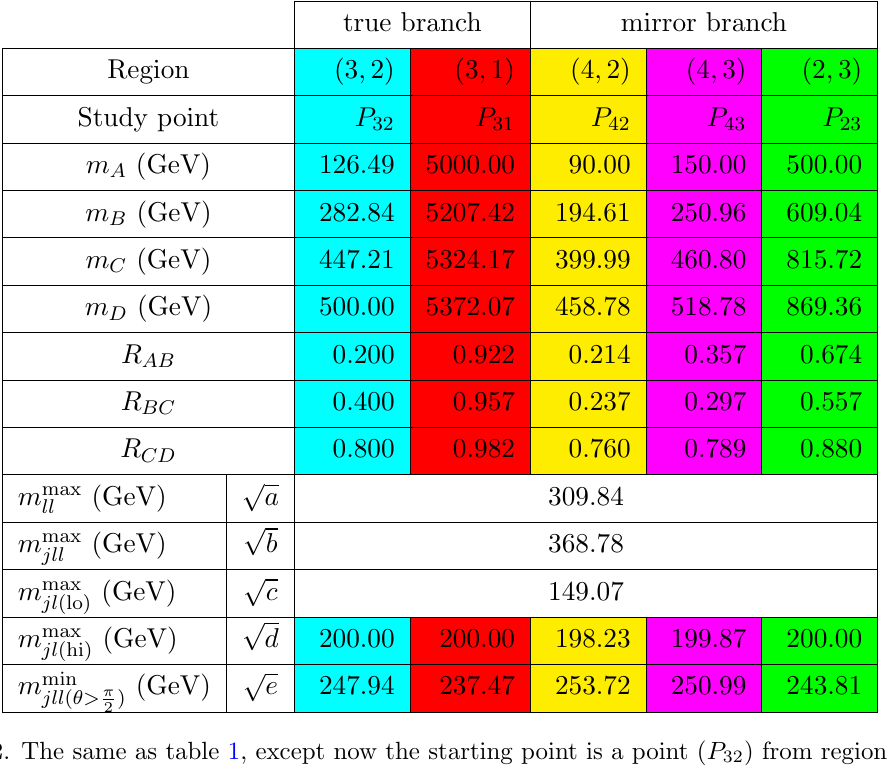
32 ) from region (3 ; 2).